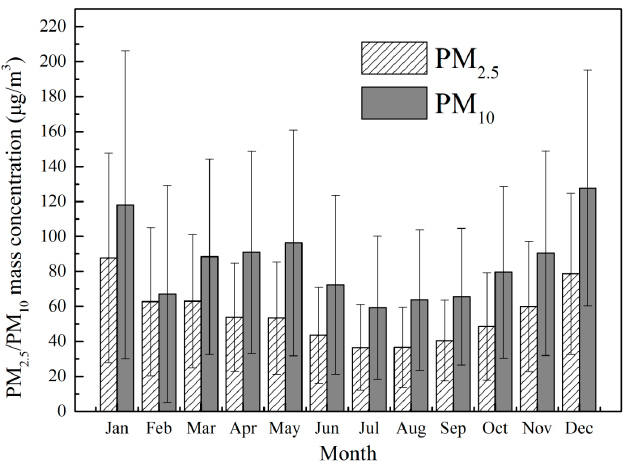
Figure 7. Monthly variations of PM 2.5 , and PM 10 in Hangzhou City for the years 2014–2016.